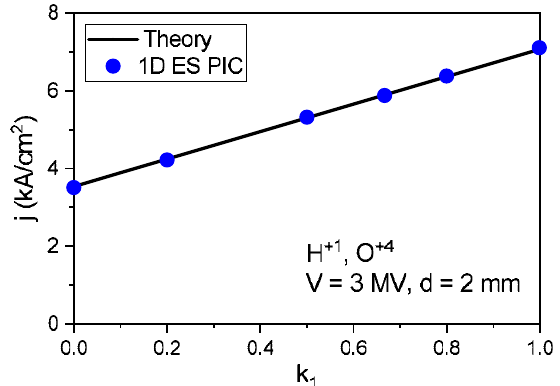
FIG. 10. Multiple ion species current density for H þ 1 and O þ 4 ions at V ¼ 3 MV and d ¼ 2 mm. The solid black line is from Eq. (C5) and the blue points are from 1D ES PIC